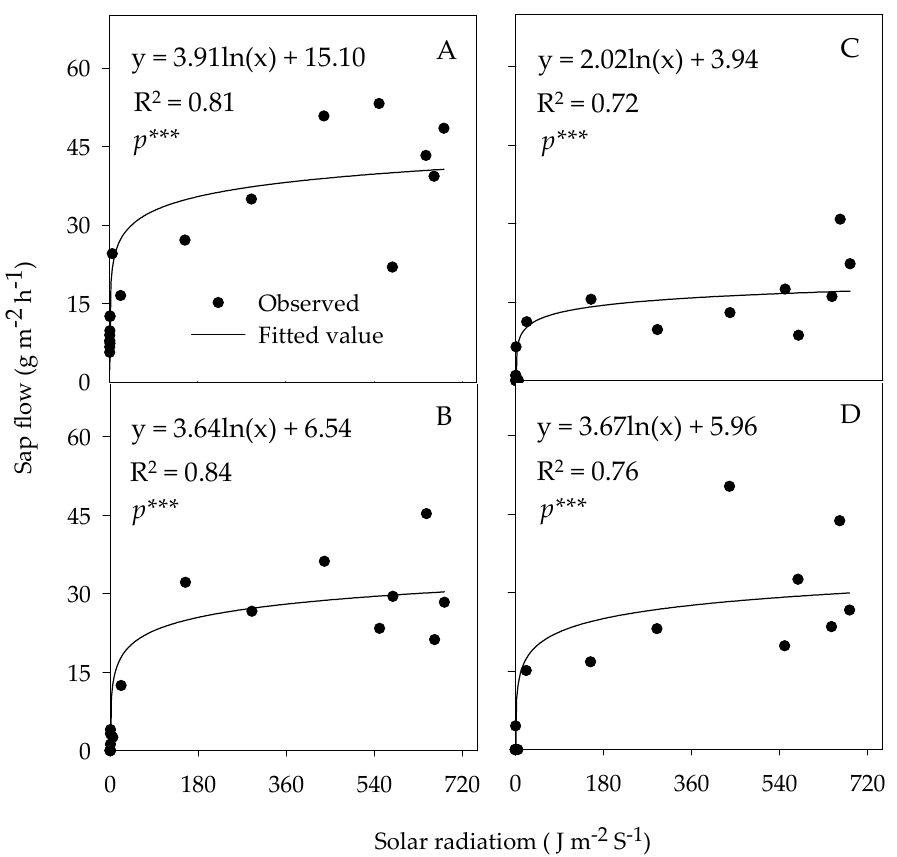
Figure 3. Logarithmic regression of sap flow and solar radiation of Huanglongbing (HLB)-affected Hamlin citrus trees under control ( A ), full Ca dose ( B ), full Mg dose ( C ), and half Ca and half Mg doses ( D ), (full dose = 45 kg ha − 1 ) treated trees. NS, *** Non-significant or significant at p < 0.0001.